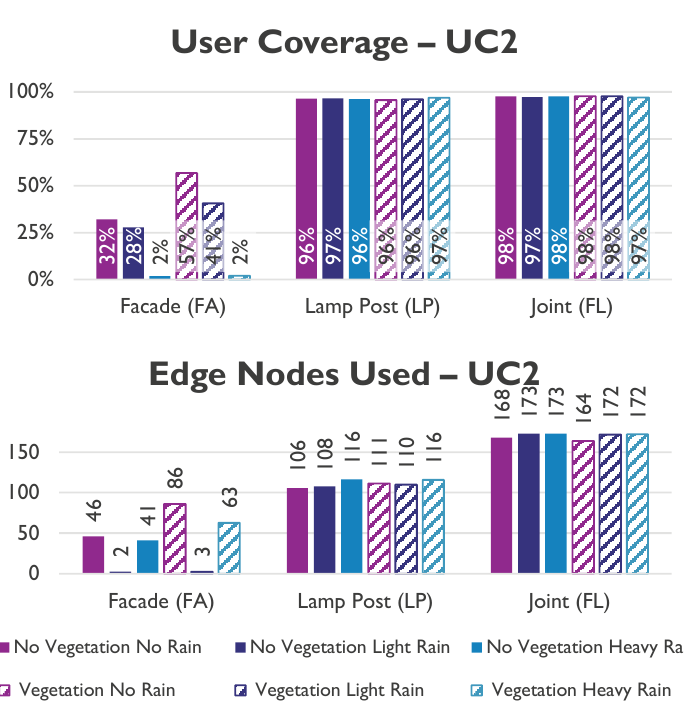
Figure 11. User coverage and network utilisation in UC